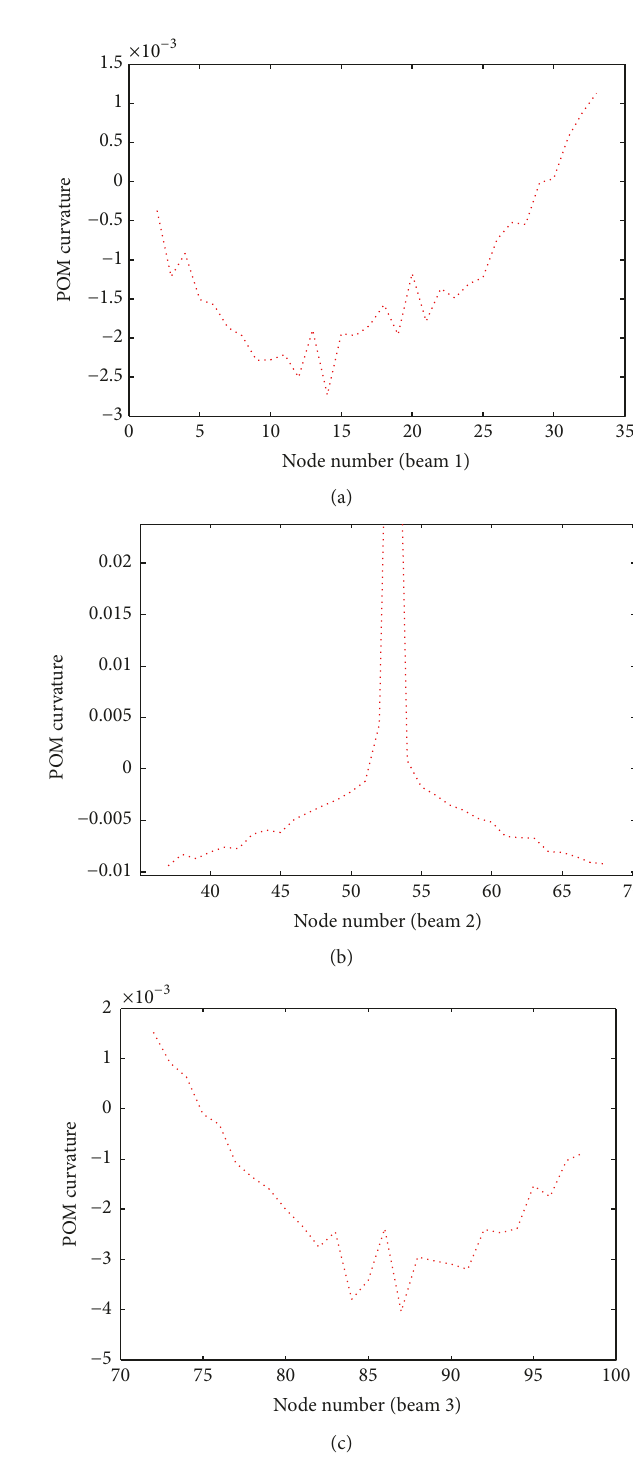
Figure 9: POM curvature curves using FRFs in the region (D) containing 1% external noise: (a) beam 1, (b) beam 2, (c) beam 3.